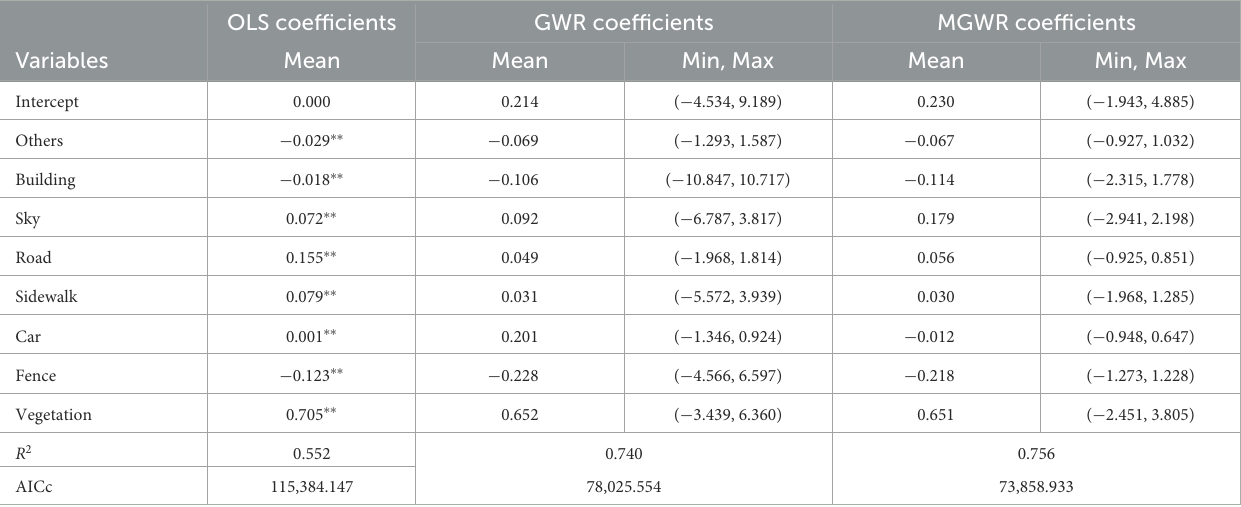
TABLE 5 Model regression results.